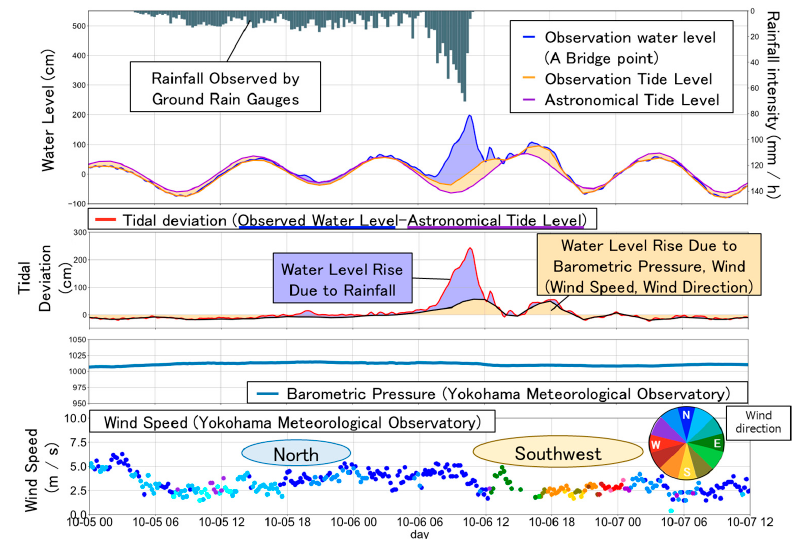
Figure 4. The relationship between water level deviation and weather conditions (at the time of Typhoon Phanfone making landfall in 2014).